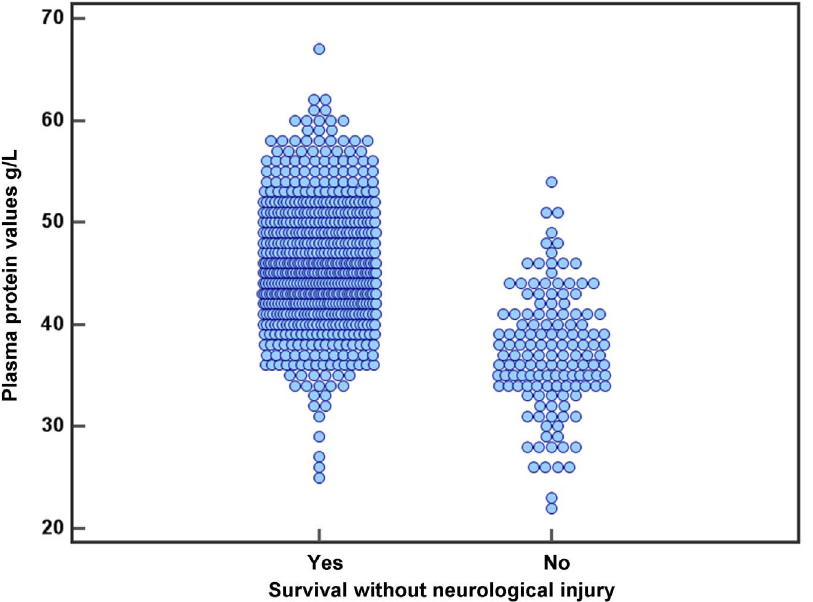
Figure 1. Scattergram demonstrating the total plasma protein values in infants with severe adverse outcome compared to those who survived without severe neurological injury.